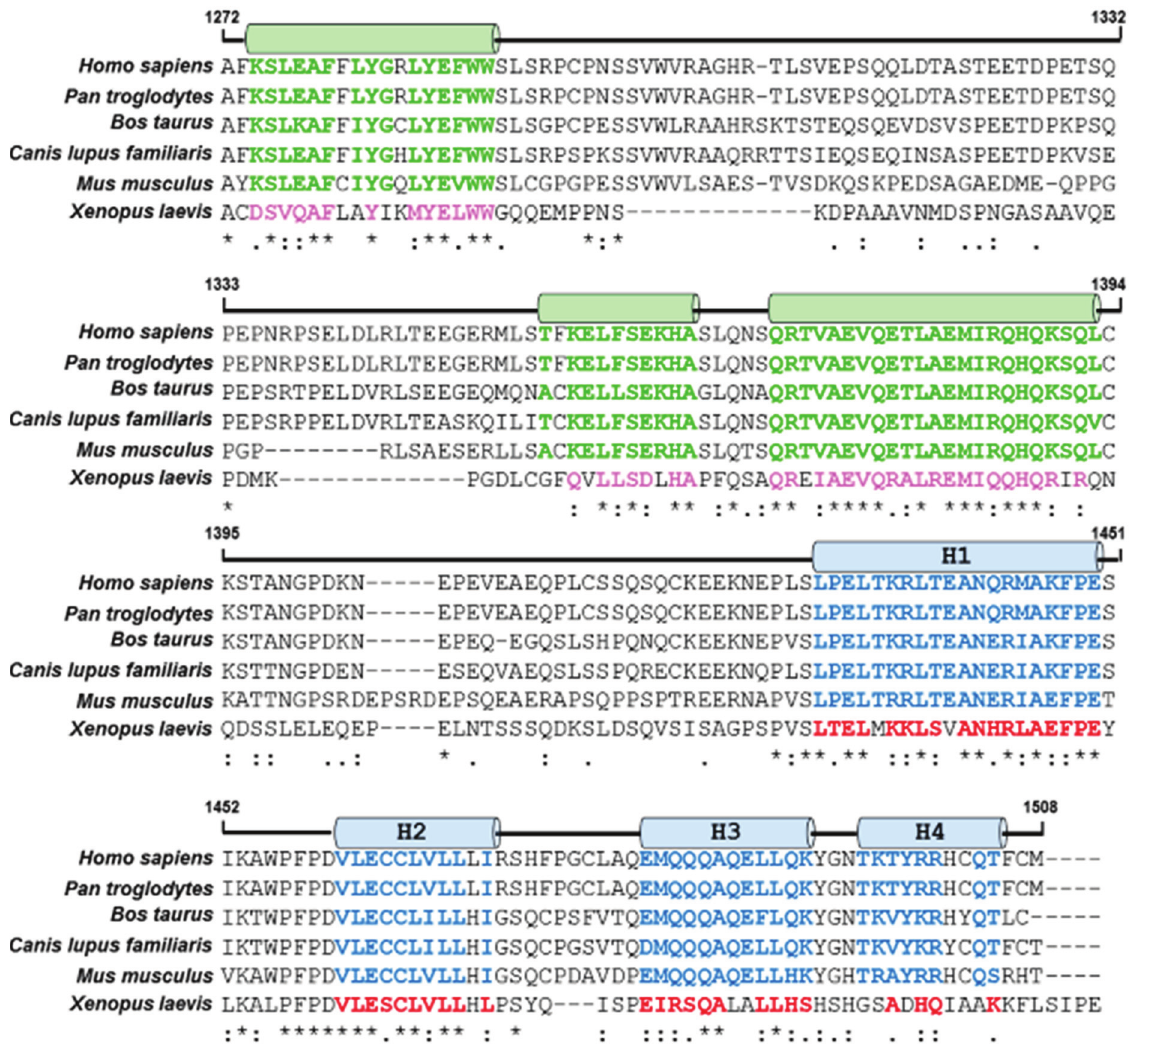
Figure 3. Multiple sequence alignment of Gemin5 sequences spanning the C-terminal region of the protein. Polypeptide RBS1 spans residues 1297 to 1412, while RBS2 spans residues 1383 to 1508. Green or blue cylinders depict the helical region of RBS1 or RBS2, respectively. The amino acids conserved in RBS1 or RBS2 in mammals are depicted by green or blue letters, respectively. Pink or red letters depict amino acids conserved in the Xenopus sequence in RBS1 or RBS2,